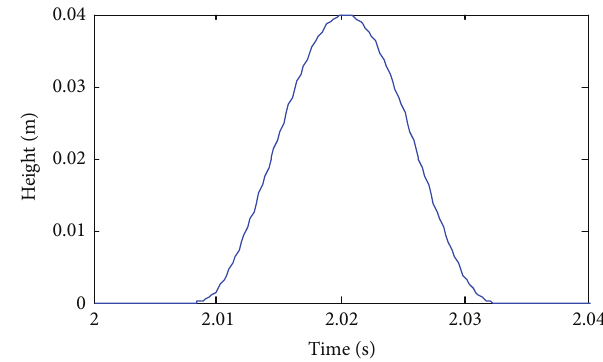
Figure 4: Sin bump